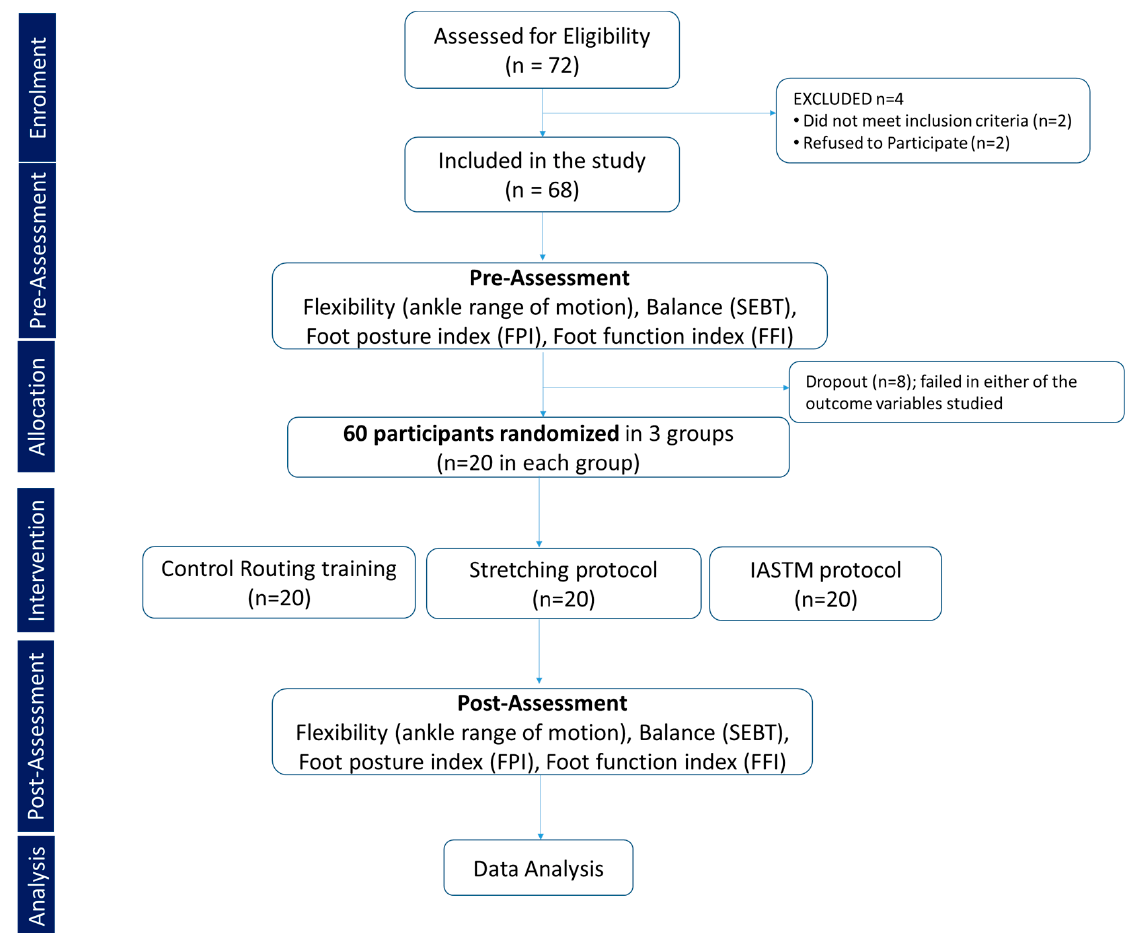
Figure 1. Consort flow chart.